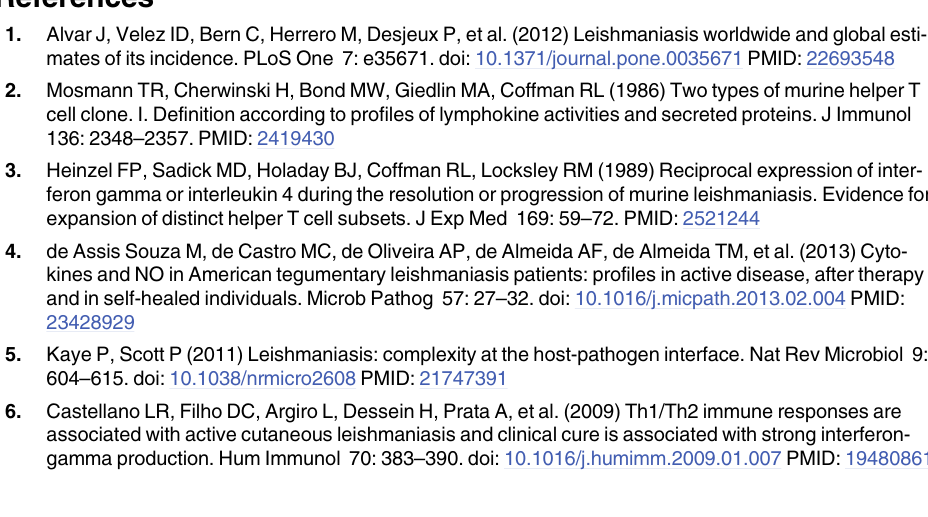
S6 Fig. Identification of responding populations by CFDA-SE labeling and flow cytometry analysis. Representative sample showing gating strategy and identification of the proliferative fraction of lymphocytes. S7 Fig. Identification of Treg cells from thawed PBMC. Gating example showing Treg cells were identified as viable lymphocytes positive for CD3 and CD4 expressing high levels of CD25 and positive for the transcription factor